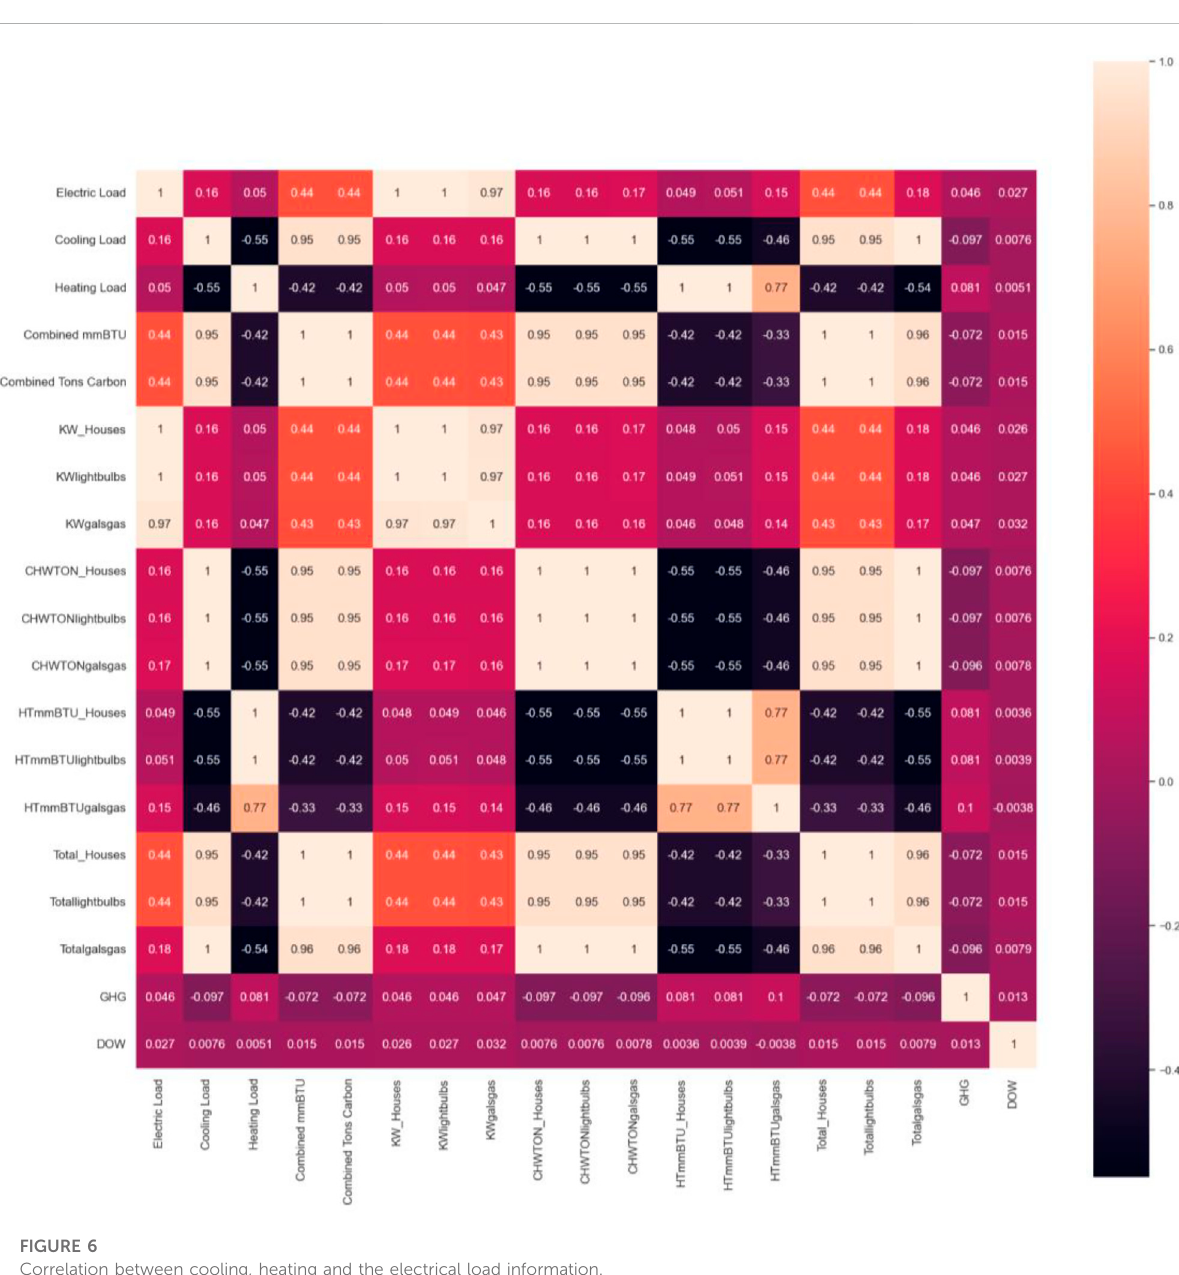
and 2 independent network branches. A simple linear layer gives the fi nal model output, which corresponds to the R Forecast arrow in the fi gure.Theotheronehasthesamestructure.Itsfunctionistomakea difference with the input of the block and use it as the input of the next block, so as to remove the information in the input features that are not highly related to the prediction, which corresponds to the R Backcast arrow in the fi gure. The speci fi c calculation is as follows: